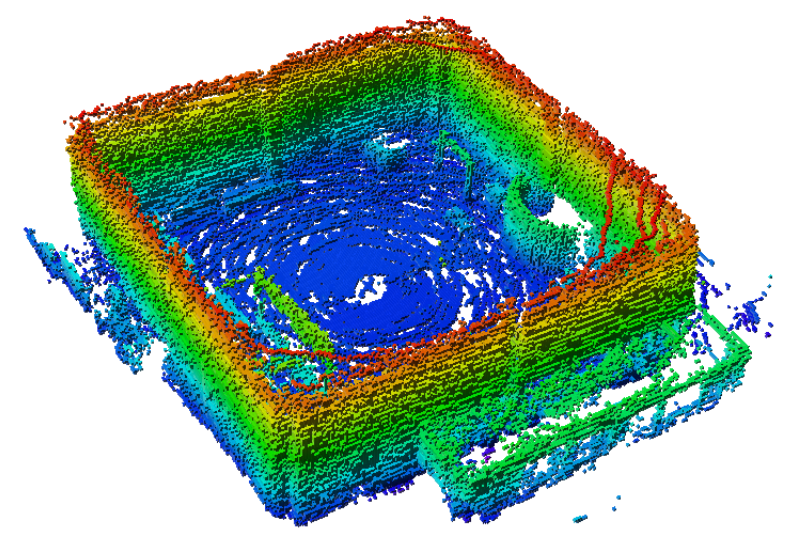
Figure 5. Three-dimensional map of the indoor testbed at